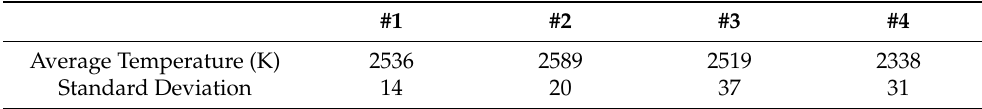
Table 11. The average and standard deviation of reaction flame temperature of the four kinds of specimens.